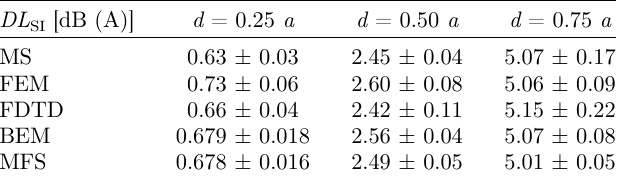
Table 2. DL SI values calculated with the limit values of the control parameters for each numerical method and for each of the diameters referred